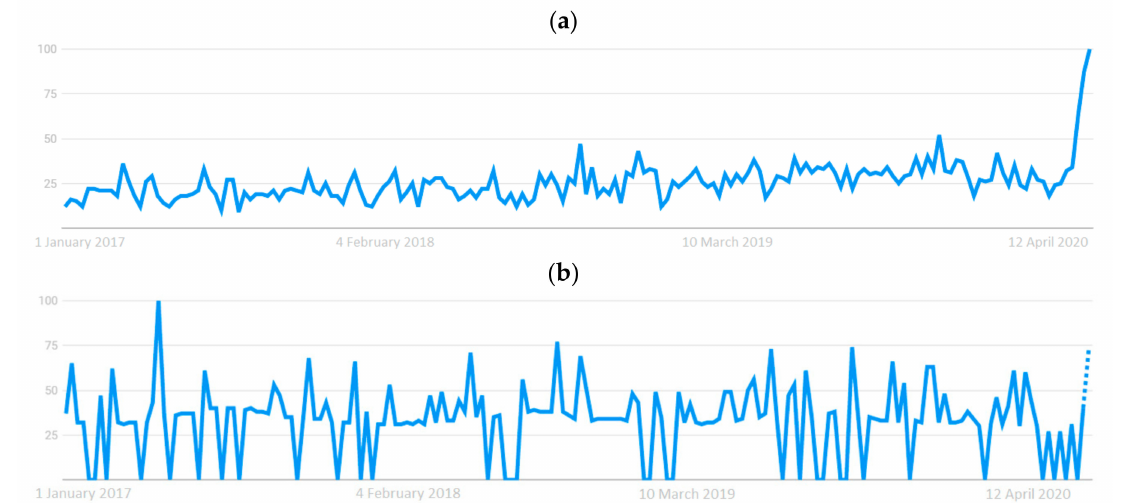
Figure 1. Relevance of Building Information Modeling (BIM) in Russia: ( a ) for the search query “BIM” in Google; ( b ) for the search query “BIM technology” in